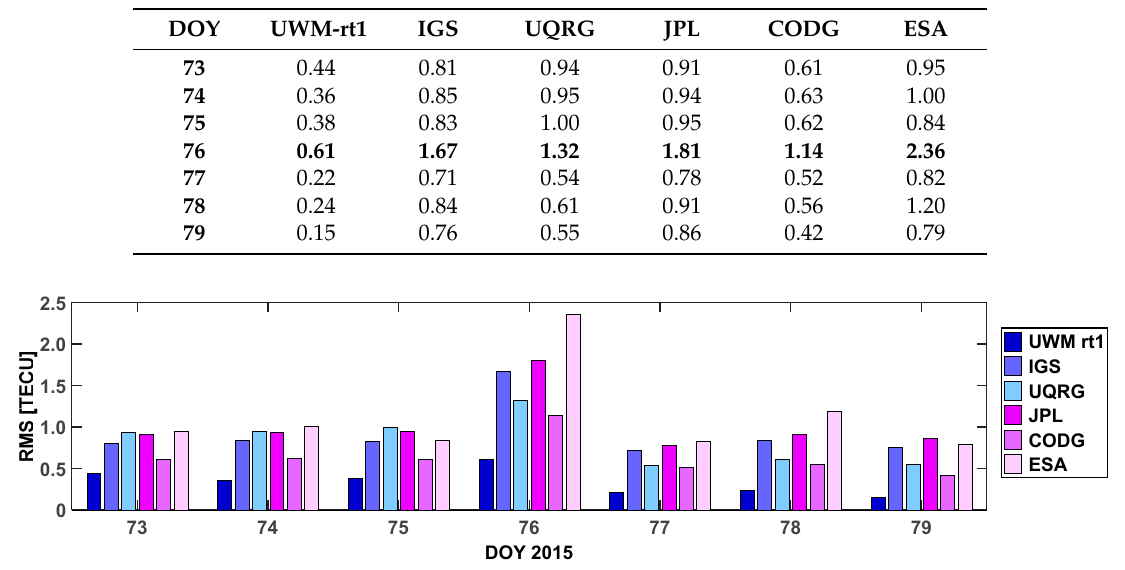
Table 1. Root mean error (RMS) of post fit residuals for the analyzed TEC maps (TECU). The stormy